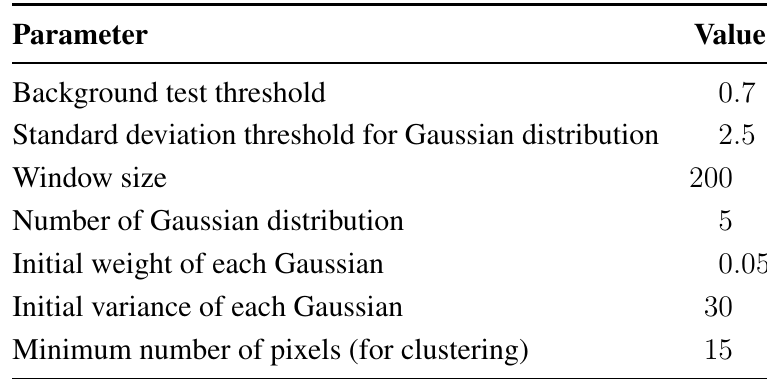
Table 1. Parameters used for the mixture of Gaussian method.